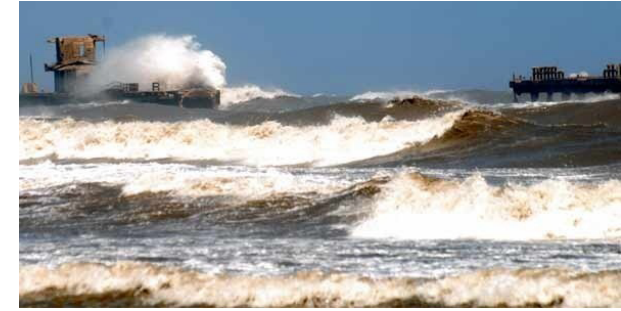
Fig. 14. Extreme waves due to the cold front that passed in March 2009 (Ortiz et al.,